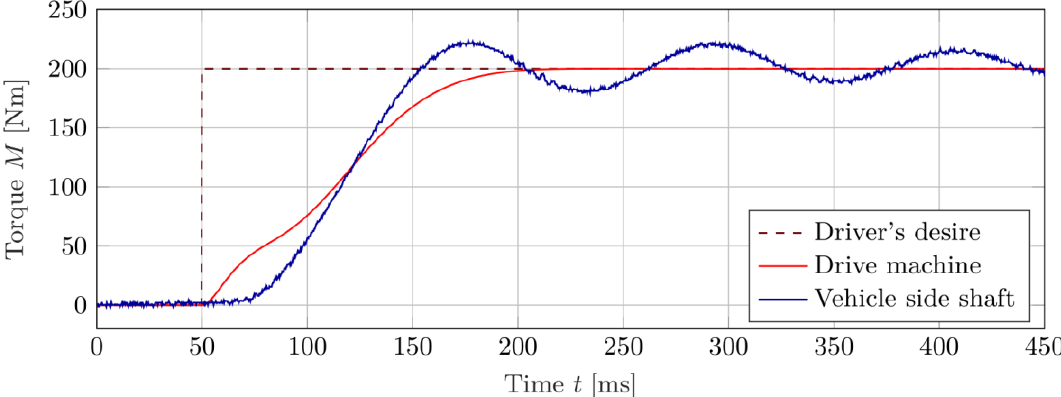
Figure 11. Torque curves as a result of the setpoint step in the driver′s desired torque with prefilter and without anti-jerk control while driving off.